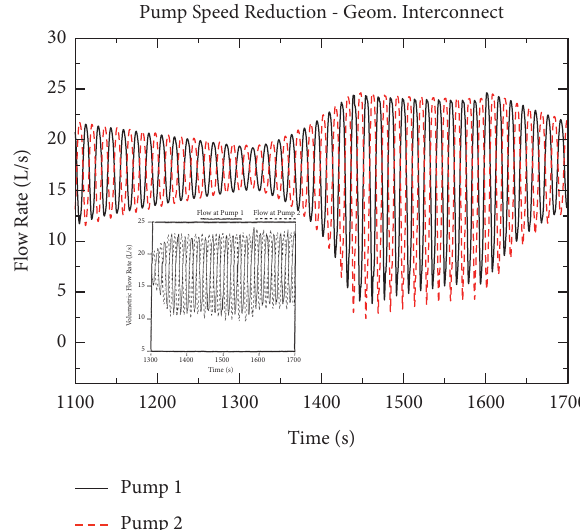
Figure 38: Flow oscillations with reduced pump speed with geometric similarity interconnect. Experiment inset [21].